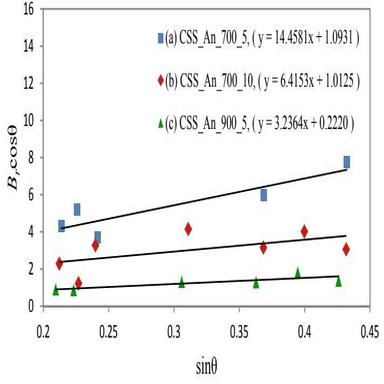
Relation of Brcos and sin for average crystallite size of samples by Scherrer equation.